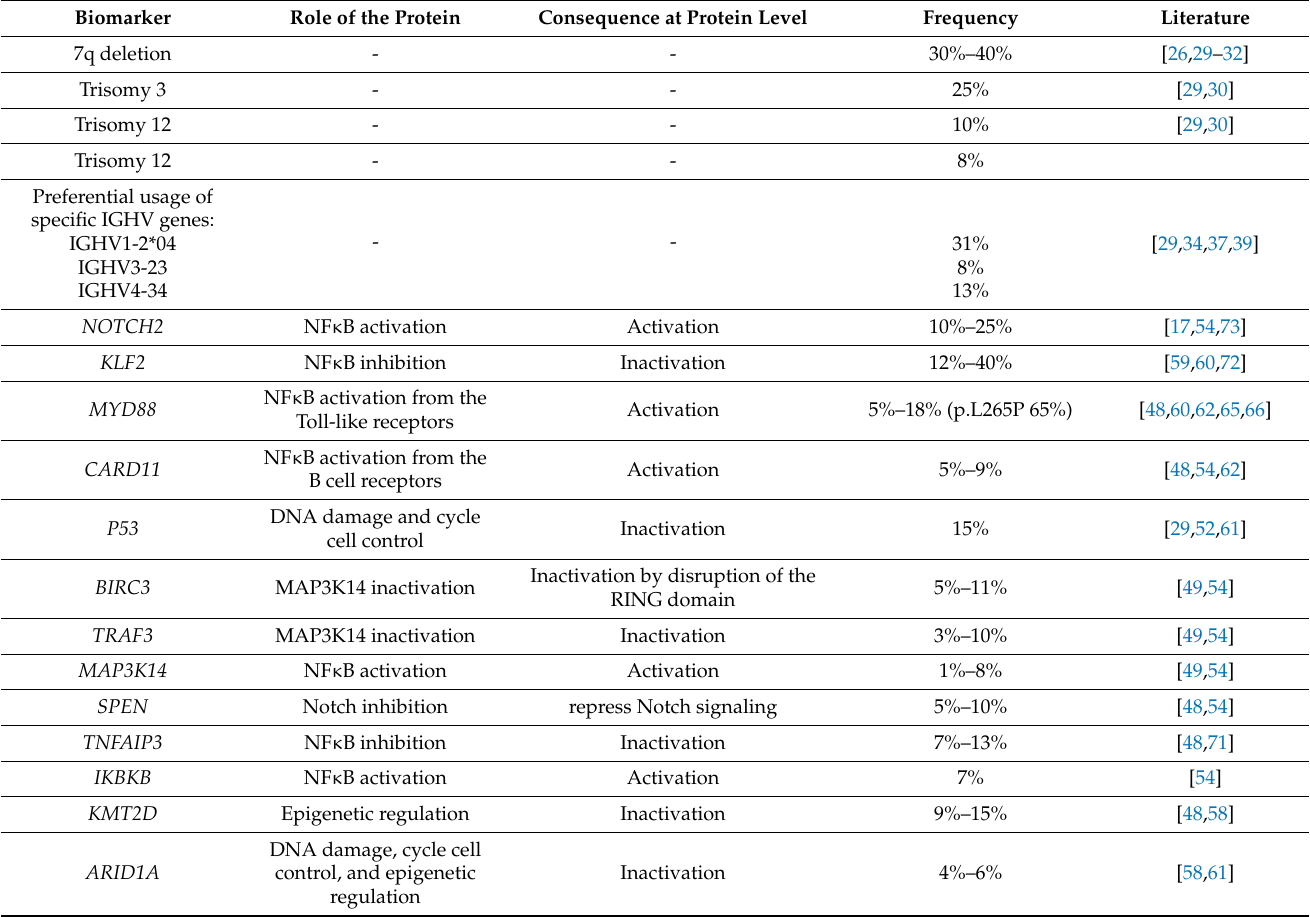
Table 1. Summarizing the principal SMZL